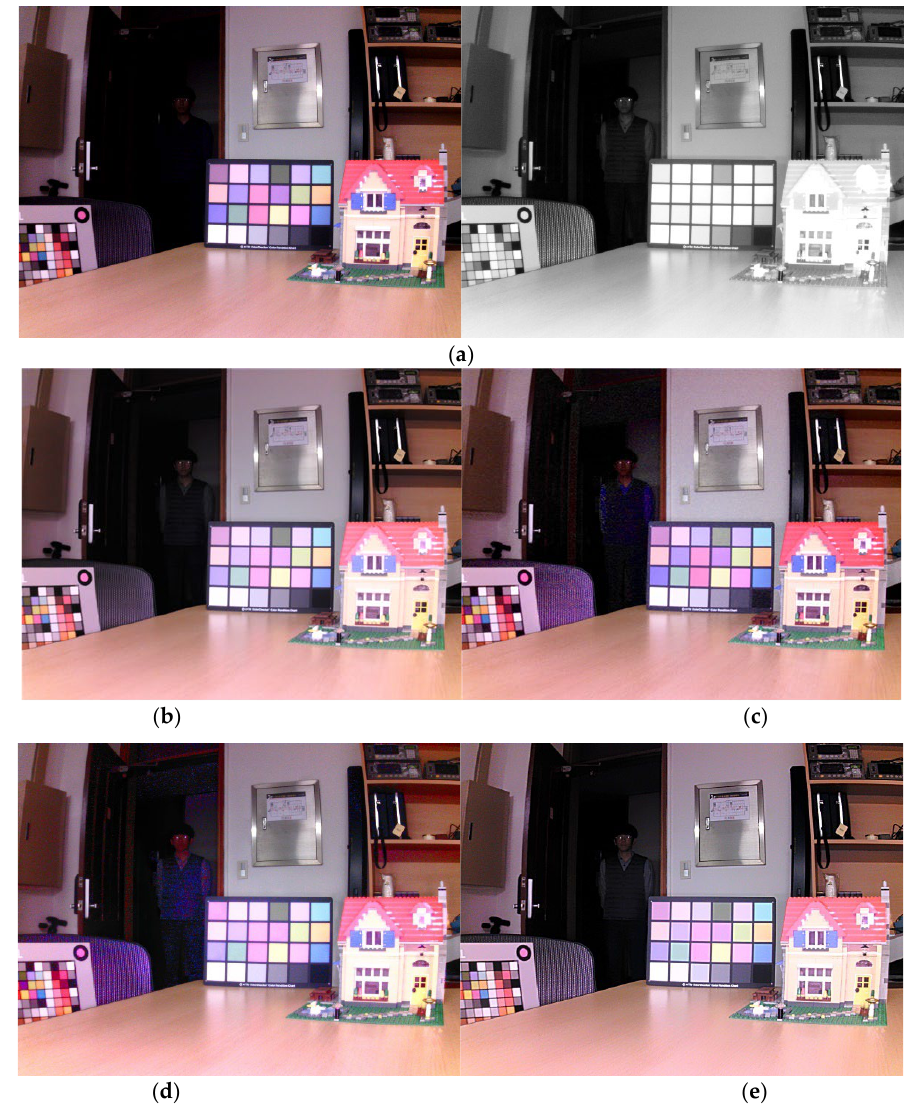
Figure 17. Nighttime input and result images (2): ( a ) visible-light image and near-infrared image, ( b ) Densefuse method result, ( c ) Vanmali method result, ( d ) PCA method result, ( e ) proposed method result.